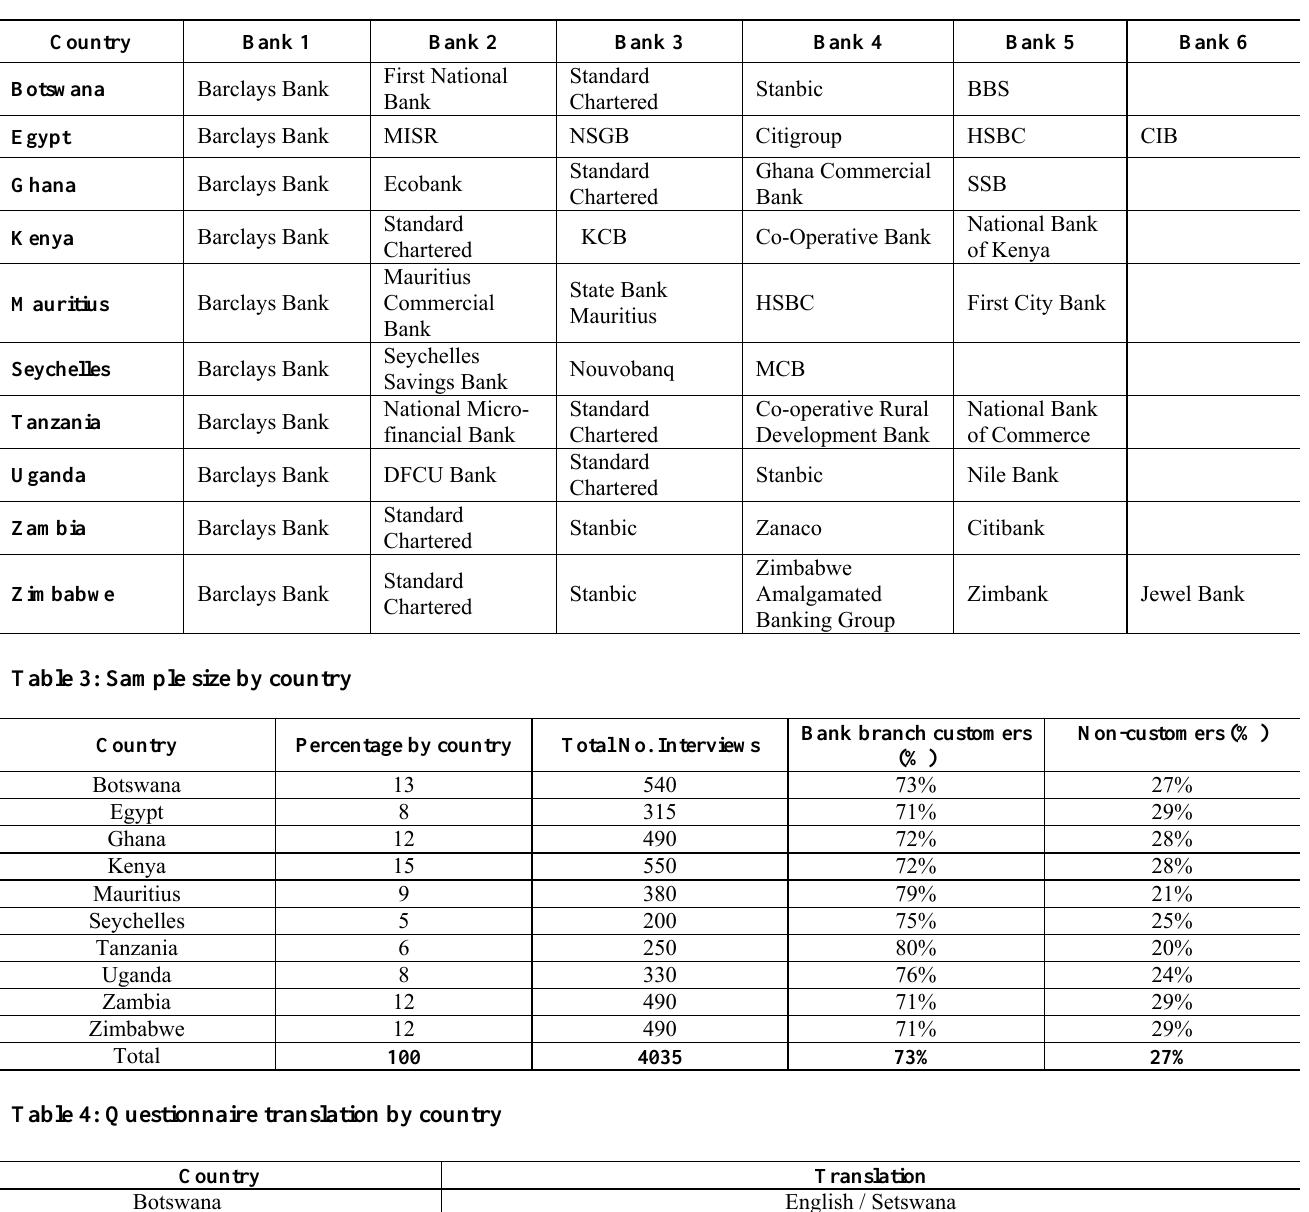
Table 2: Surveyed countries and respective retail banks